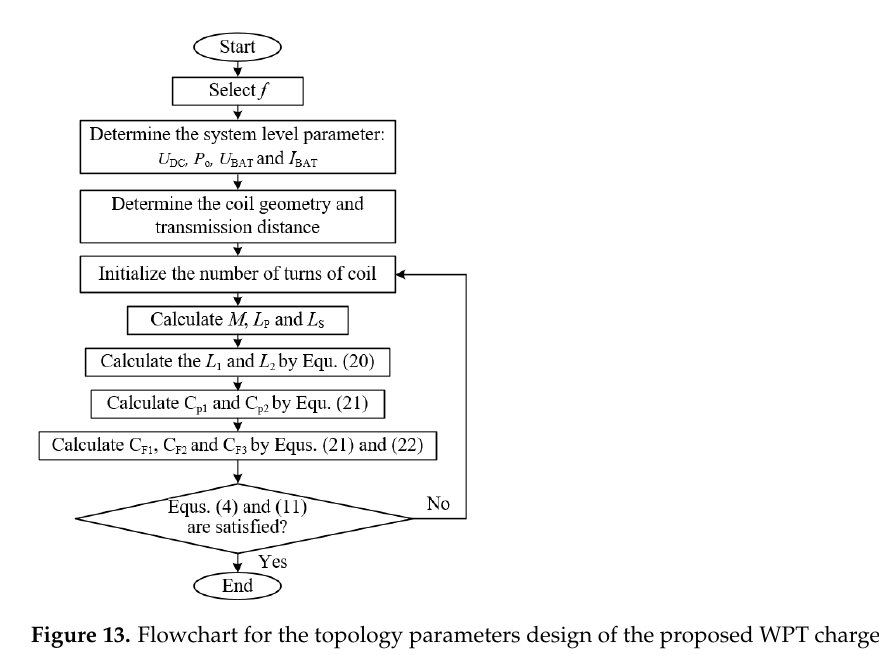
Figure 14. Experimental prototype of the proposed WPT battery charger.